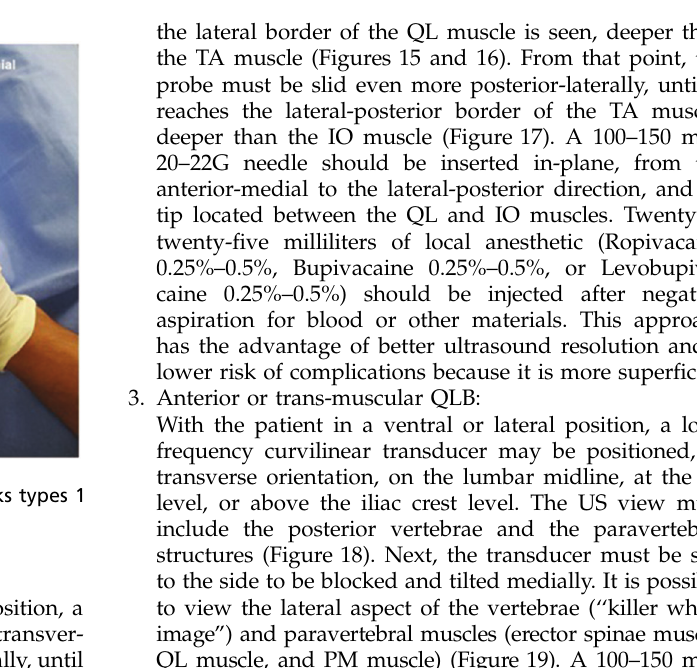
Figure 14 - US image, with the projection needle, with the tip located in the plane between the IO and TA muscles. ASIS: anterior superior iliac spine.